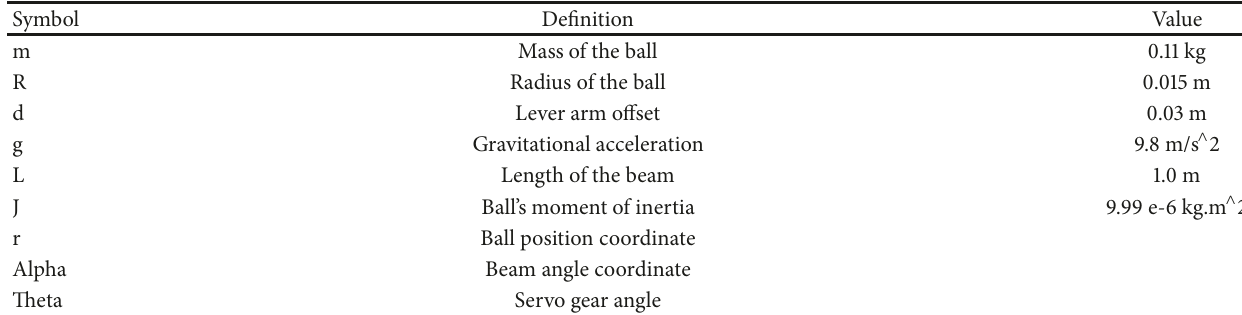
Table 5: Variables of ball and beam system.